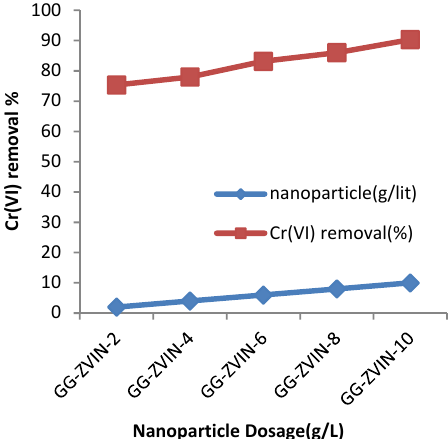
Fig.5.The removal efficiency of Cr(VI) using PVP- ZVINs as a function of PVP- ZVINs dosage